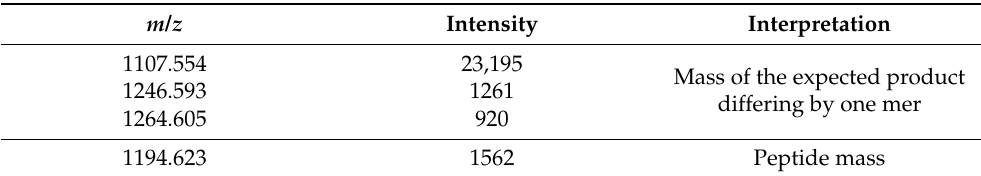
Table 3. Analysis of the characteristic peaks from the MS spectrum of the obtained polysaccharide– H-FFPLADDVTP-OH